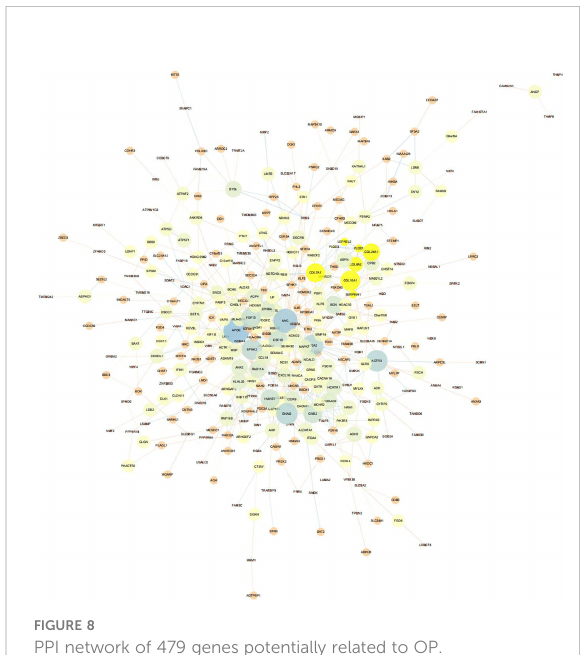
FIGURE 8 PPI network of 479 genes potentially related to